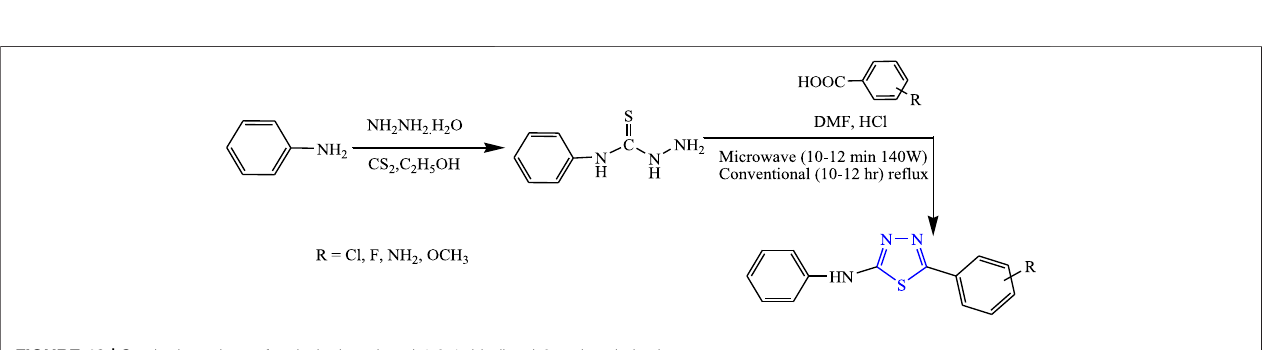
Frontiers in Chemistry |